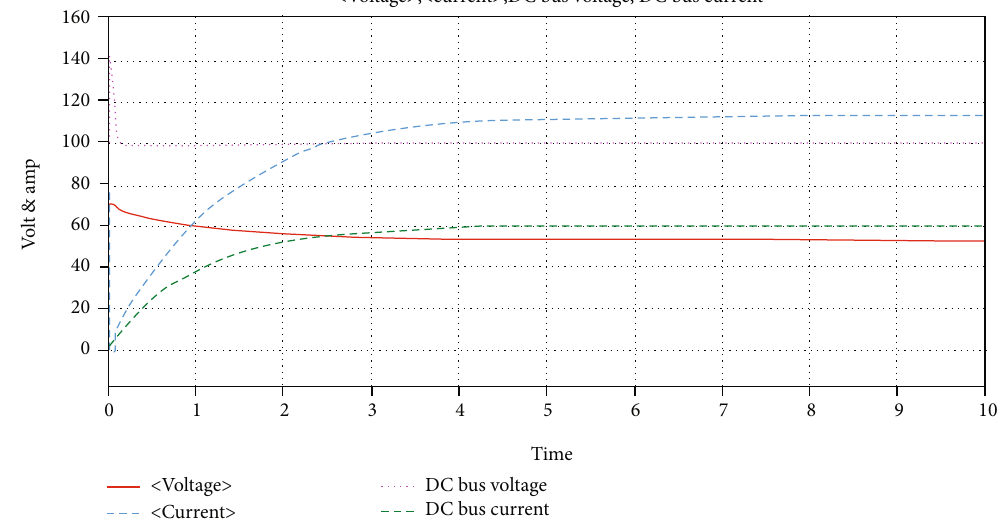
Figure 19: Simulation results for DNN-fuel cell converter voltage and current as well as DC bus voltage and current.